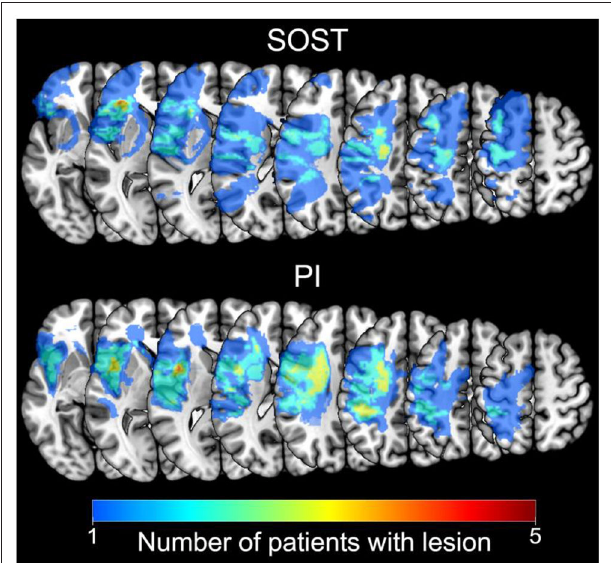
FIGURE 1 | Lesion Maps. Superposition of patients’ lesions represented by the number of subjects that had lesions in each voxel. Left hemisphere lesion maps are presented separately for each group: patients that received Semantic Organization Strategy Training (SOST; n = 7; top); and patients that received Psychoeducation Intervention (PI; n = 6; bottom). Images in neurological